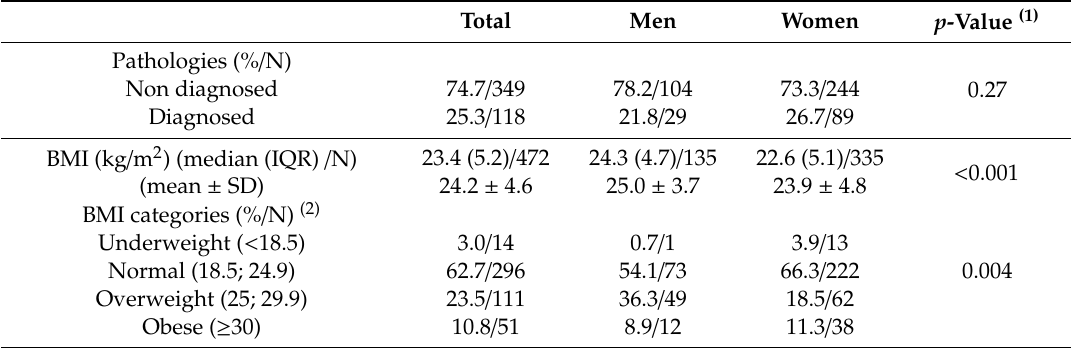
Table 3. Presence of diagnosed pathologies, BMI, and gender comparison.